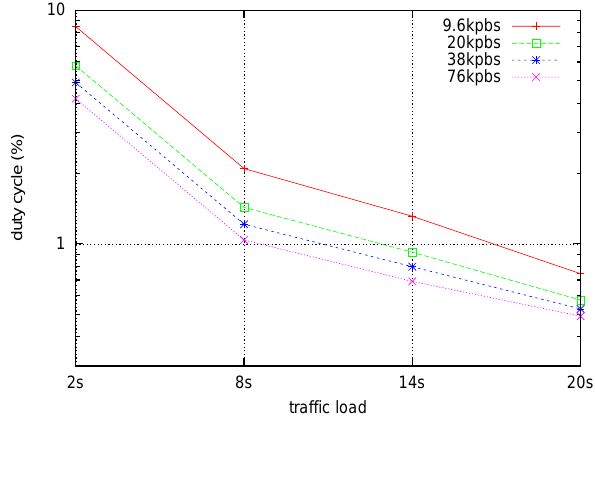
Figure 4 . The network radio duty cycles at different traffic loads—note the log scale in